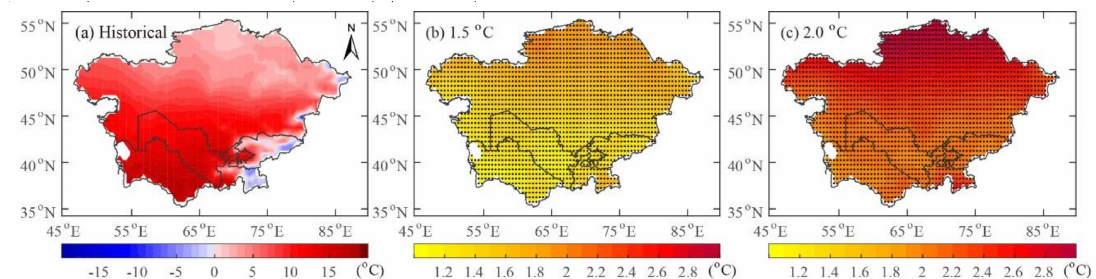
Figure 3. The spatial distribution of annual mean temperature (TAVG) in the reference period (1986–2005) ( a ) and the di ff erence under 1.5 ◦ C ( b ) and 2 ◦ C ( c ) global warming relative to the reference period. Dark gray dots indicate that the increasing trends are significant at the 1% level in these